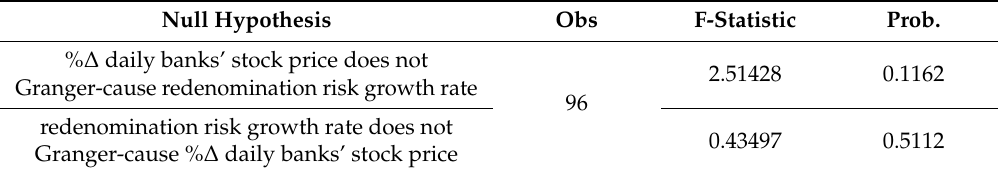
Table 6. Granger-causality test: period March 2018–September 2018.